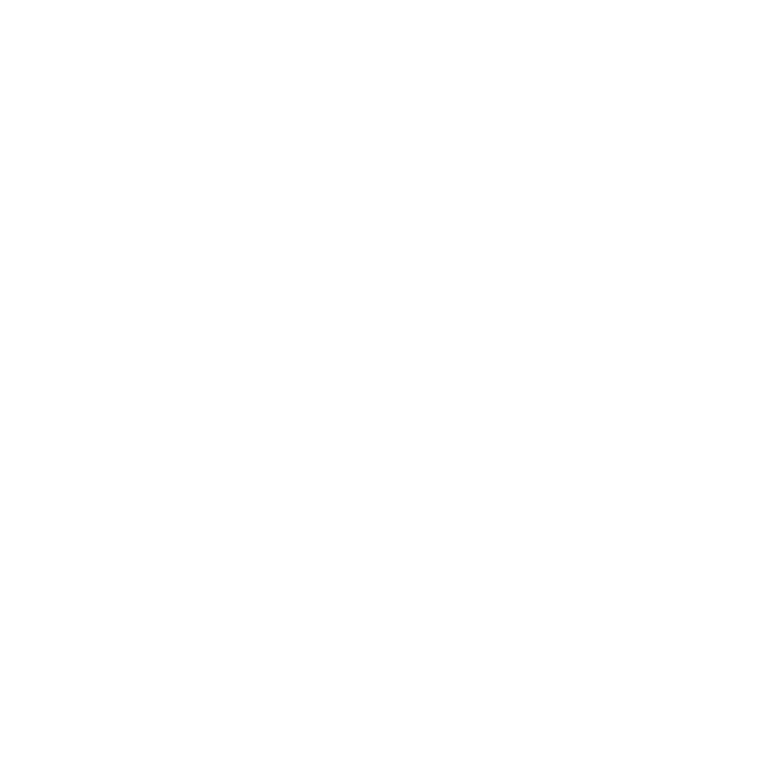
Frontiers in Microbiology | Antimicrobials, Resistance and